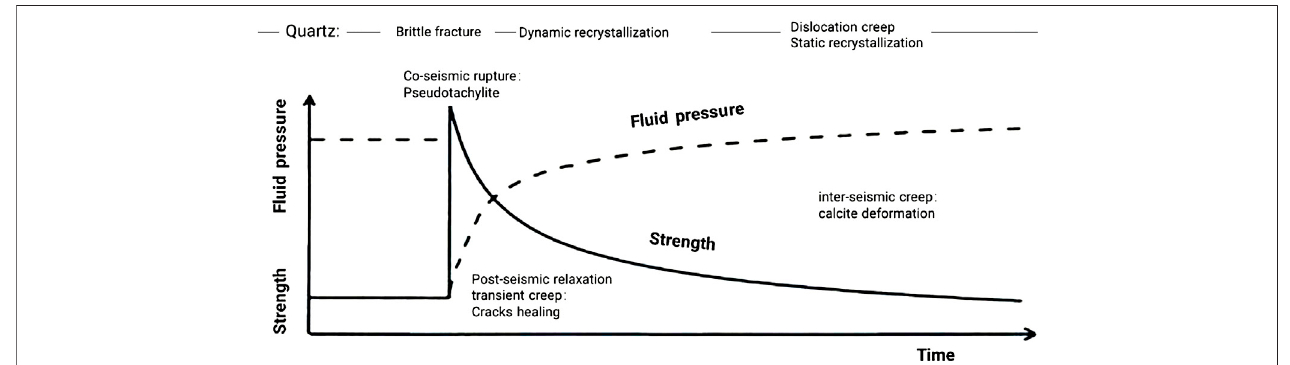
FIGURE7| Transientcreepmodelofquartzfromco-seismic ruptureandpost-seismicrelaxation tointer-seismicductile inthebrittle – plastictransitionofRedRiver fault (modi fi ed from Trepmann and Stöckhert, 2003).